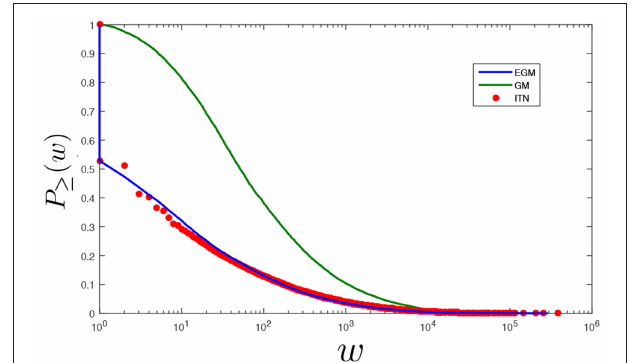
FIGURE 3 | Empirical and model-generated cumulative distributions of trade flows. Log-linear plot comparing the empirical cumulative distribution of trade flows (normalized in order to include zero flows) in the ITN for the year 2000 (red) with the corresponding distributions obtained using the Gravity Model defined in Equation (1) (green, parameters estimated as reported in Table 1 ) and the Enhanced Gravity Model defined in Equations (4) and (27) (blue, parameters estimated as reported in Table 2 ). Note the discontinuous jump due to the ≈ 47 % pairs of unconnected countries in both the empirical and the EGM-generated curves, and the absence of such a feature in the GM-generated curve (for which missing links are incorrectly given a positive